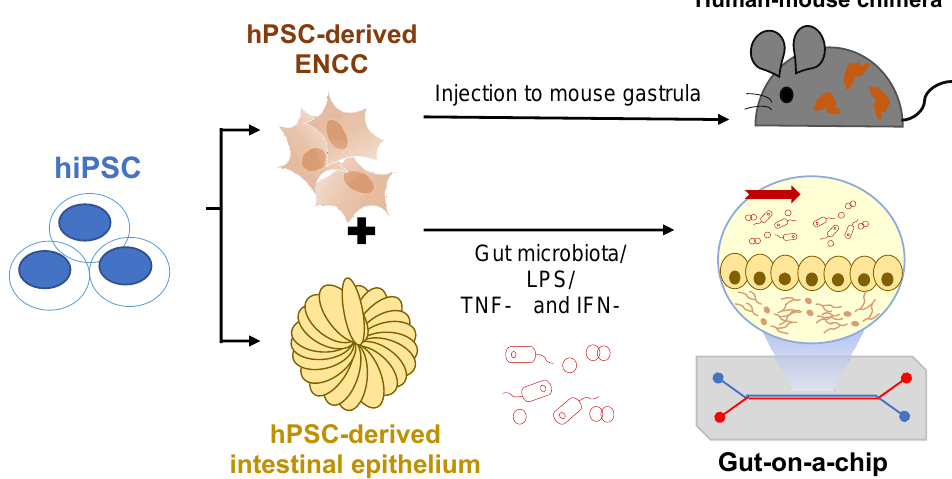
Figure 4. Future perspectives of the hPSC-based disease models. hPSC-derived NCCs can be injected into mouse gastrula to generate human-mouse chimera for in vivo disease models. Co-culture of ENCCs and intestinal epithelium with a gut-on-a-chip device allows the study of microbiota-gut- ENS interactions in HSCR. LPS: Lipopolysaccharides; TNF- α :Tumor necrosis factor-alpha; IFN- γ : Interferon-gamma.